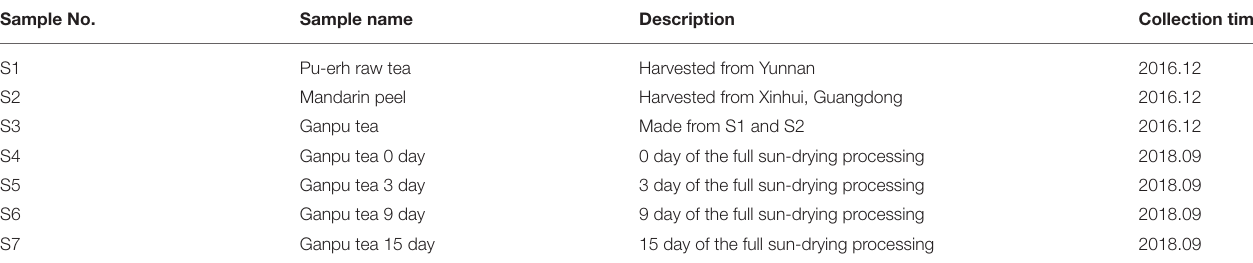
TABLE 1 | Sample information sheet. Sample